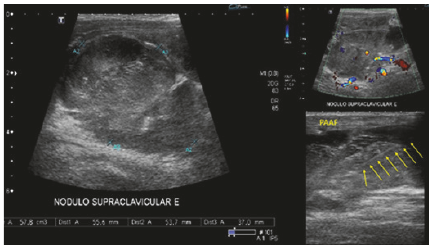
Figure 5: Ultrasonography of the neck demonstrating the shape and vascularization of left supraclavicular lymphadenopathy. It also demonstrates the puncture/biopsy by fine needle of the nodule (FNAB), highlighted by the yellow arrows.